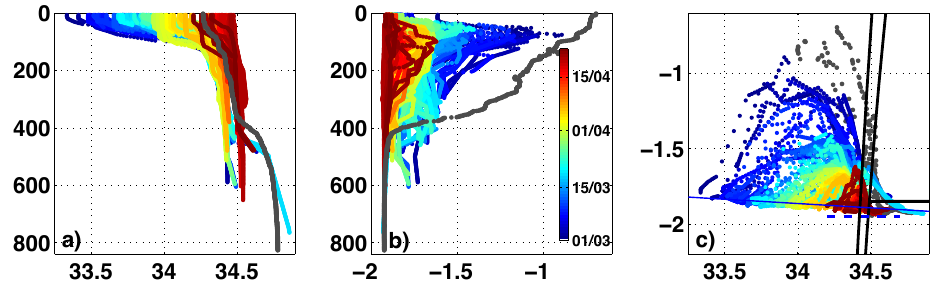
Fig. 9. IMOS seal CTD data with nearest bottled calibrated ship based CTD data from NBP00–08 (station 17), in dark gray, respectively). Panels a–b are vertical profiles of salinity and potential temperature (C ◦ ). Panel c ) is the θ − S diagram. Additional water mass boundaries, contours and freezing point line as in Fig. 4e. The color scale on all panels is the